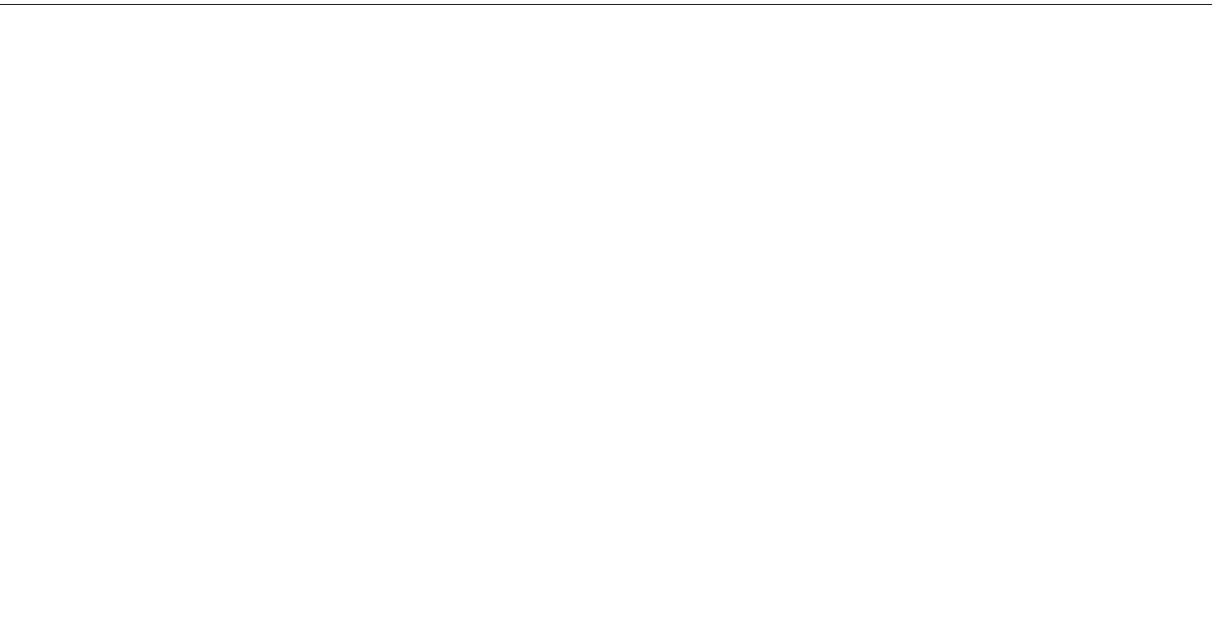
Figure A8 | Whole-brain analysis performed on the patient PS in the Arcimboldo face categorization experiment. Four areas were found to be significant, one corresponding approximately to the patient’s right “FFA,” presenting face-preferential response to faces in the localizer experiment, and three other regions, in the right prefrontal cortex and left lingual gyrus. Importantly, there was no activation in the right posterior occipital